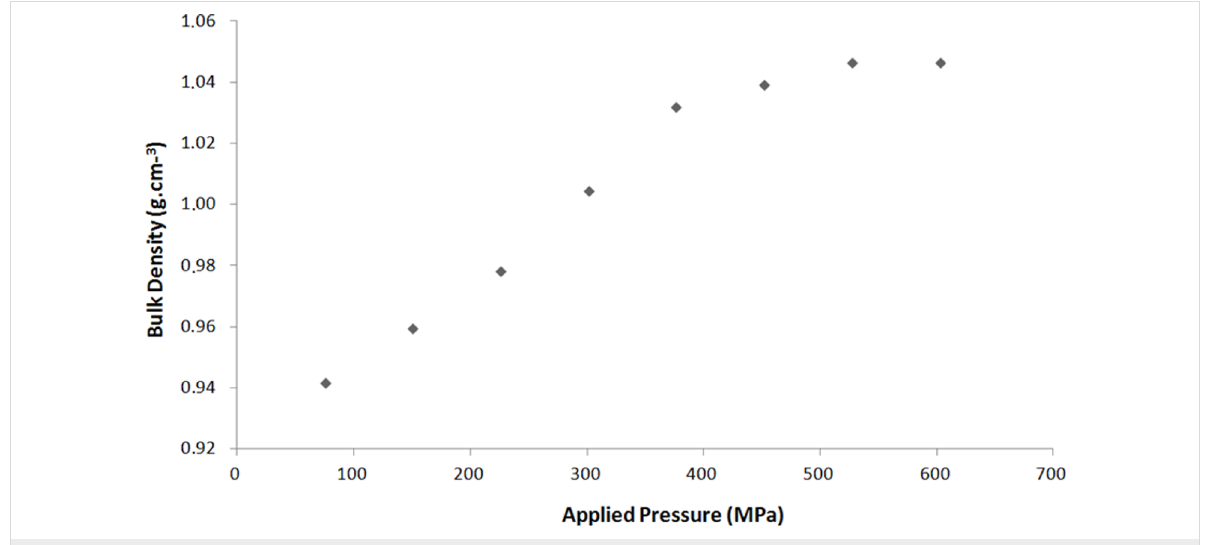
Figure 5: Bulk density as a function of the pressure applied to the mixture for 13 × 3 mm 2 pellets made with 5 wt % of binder. The pellets may be comprised of one to four zeolites.